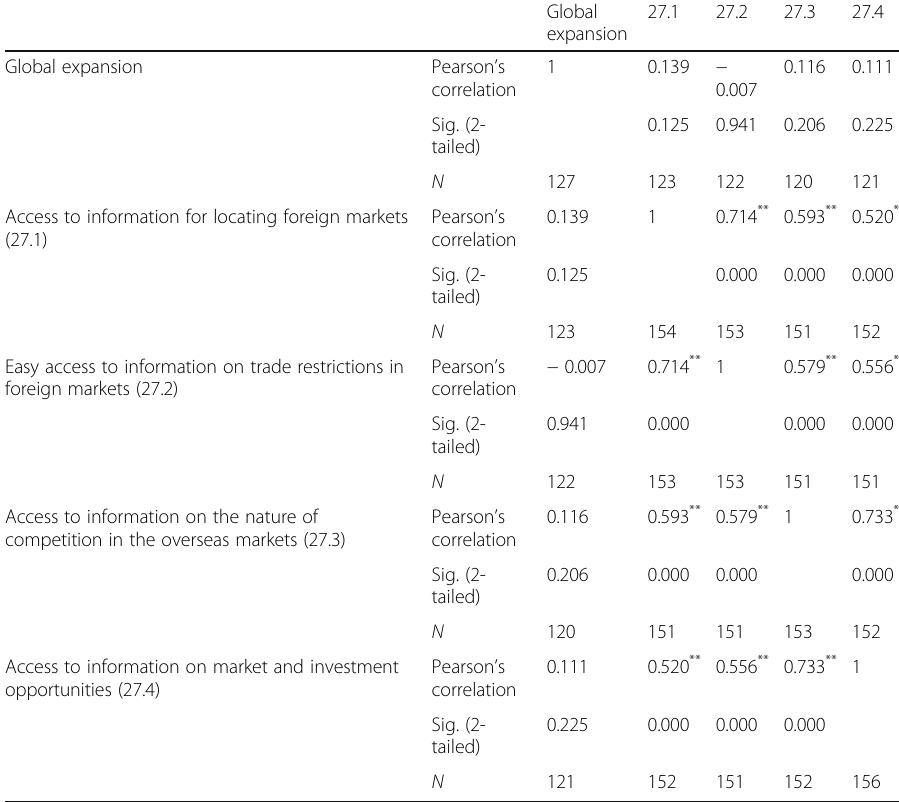
Global 27.1 27.2 27.3 27.4 expansion